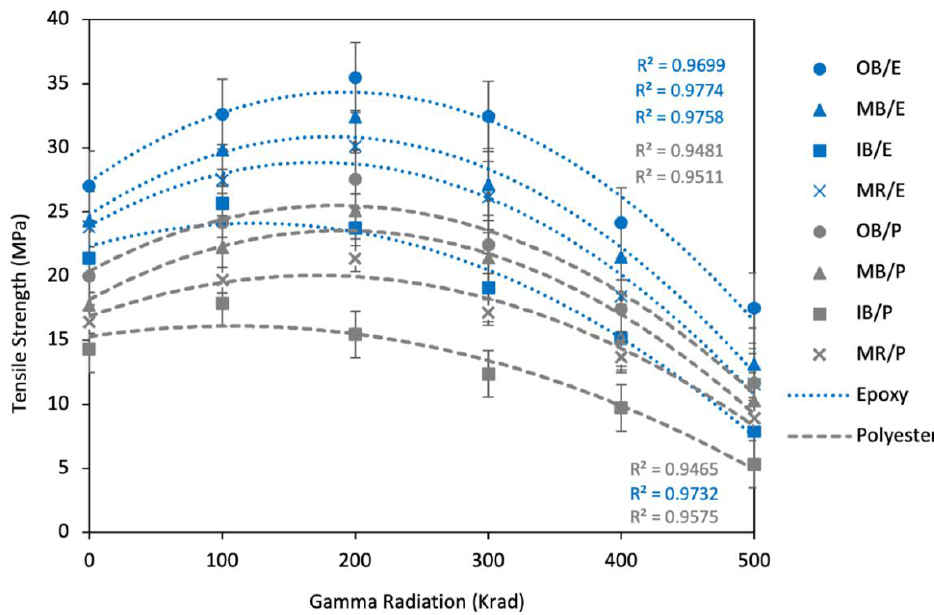
Figure 15. Effect of gamma radiation on tensile strength of the composites.